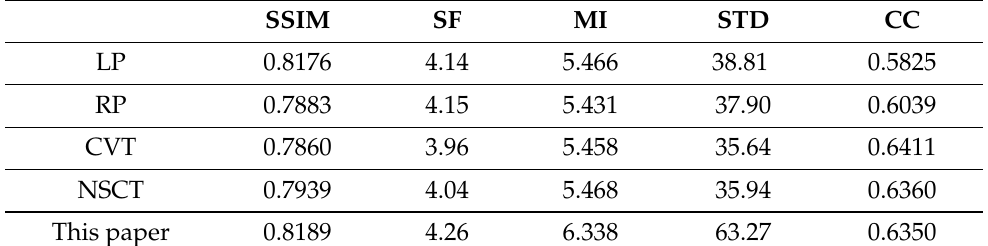
Table 3. The results of image fusion.